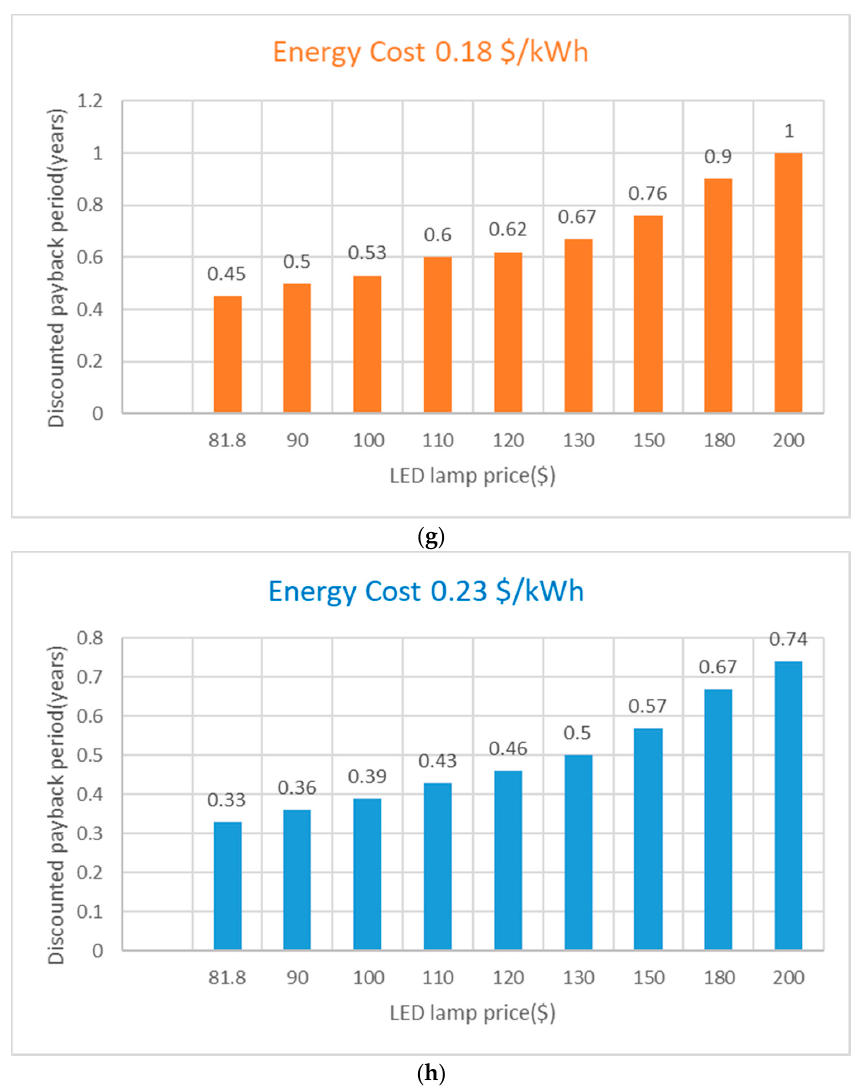
Figure 4. Effect of varied prices of electricity and LED lamp on the discounted payback period: ( a ) Energy cost 0.05 $/kWh ( b ) Energy cost 0.06 $/kWh ( c ) Energy cost 0.078 $/kWh ( d ) Energy cost 0.09 $/kWh ( e ) Energy cost 0.1 $/kWh ( f ) Energy cost 0.12 $/kWh ( g ) Energy cost 0.18 $/kWh ( h ) Energy cost 0.23 $/kWh. Table 5. Calculation of discounted payback period. The color shows the transition from negative to positive value and the parameters selected. Year Amount Discounted Cash Flow